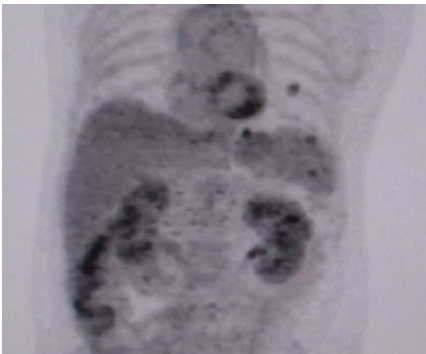
Figure 3: PET scan of the patient on day 45 of the vemurafenib treatment.